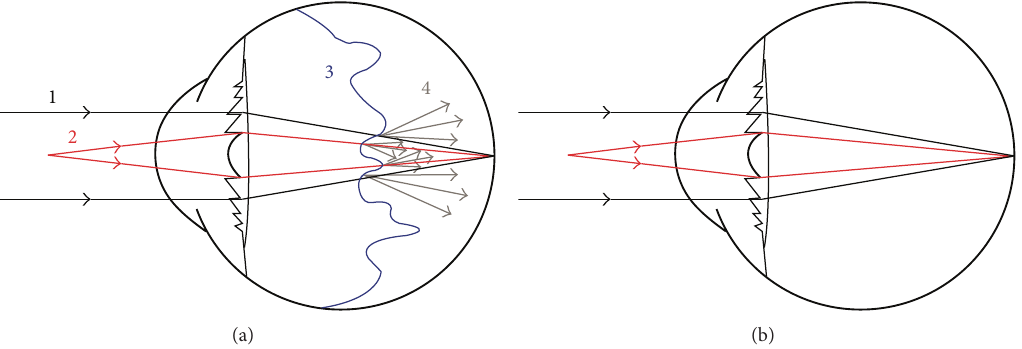
Figure 3: (a) Drawing showing an eye with a multifocal IOL and PVD. The light rays first pass through the cornea and then the IOL. The high density of the PVD causes dispersion of the light rays. (1) The light ray in black represents distance vision. (2) The light ray in red represents near vision. (3) The wavy blue line represents vitreous detachment. (4) The gray arrows show dispersion of the light rays when they pass through the dense vitreous causing halos, floaters, and blurred vision. (b) The drawing shows the light rays reaching the retina without interference from the vitreous detachment after PPV, indicating the potential for good near and distance vision without glasses. The red lines indicate the light rays for near